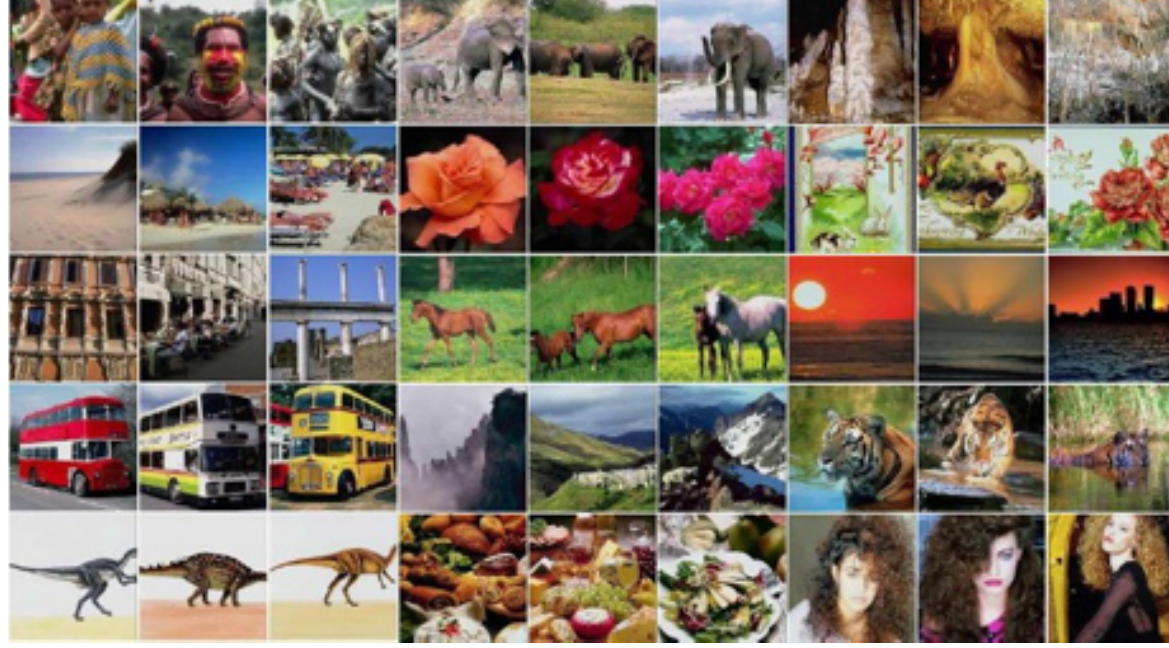
Figure 1. Three sample images from each of the 15 classes in the COREL